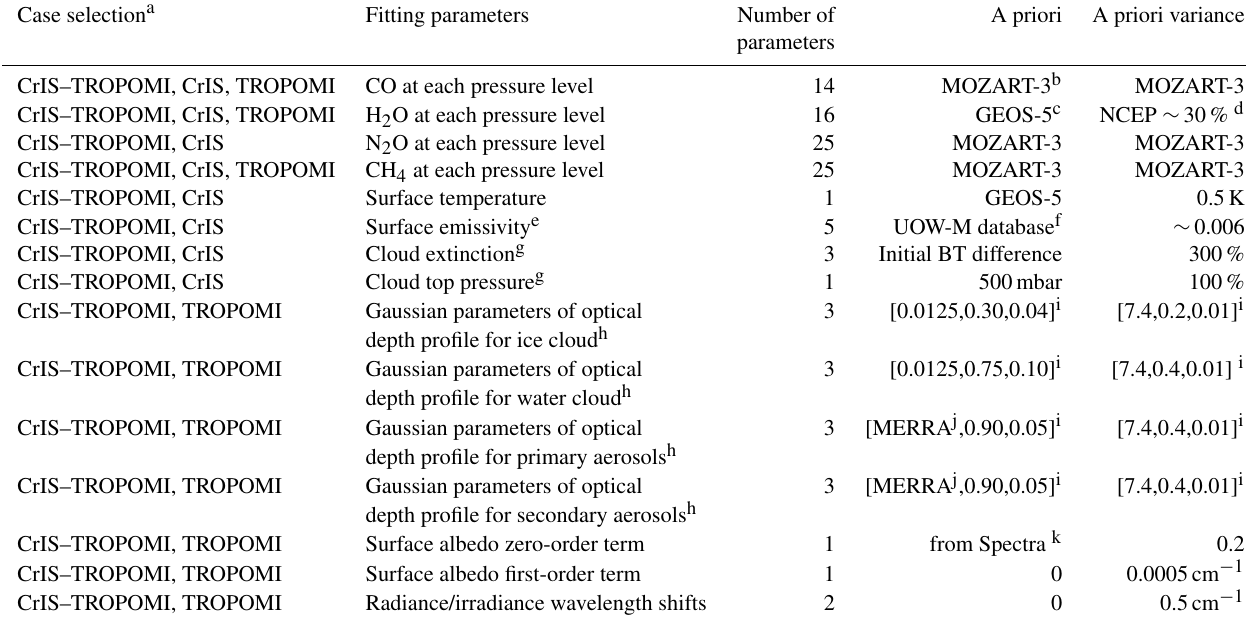
Table 2. List of parameters in state